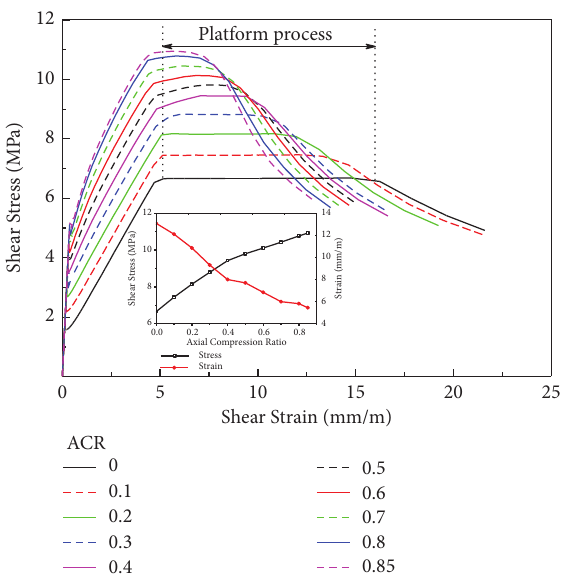
Figure 11: Relationship curve of shear strain and stress of core region subjected to different vertical stress.